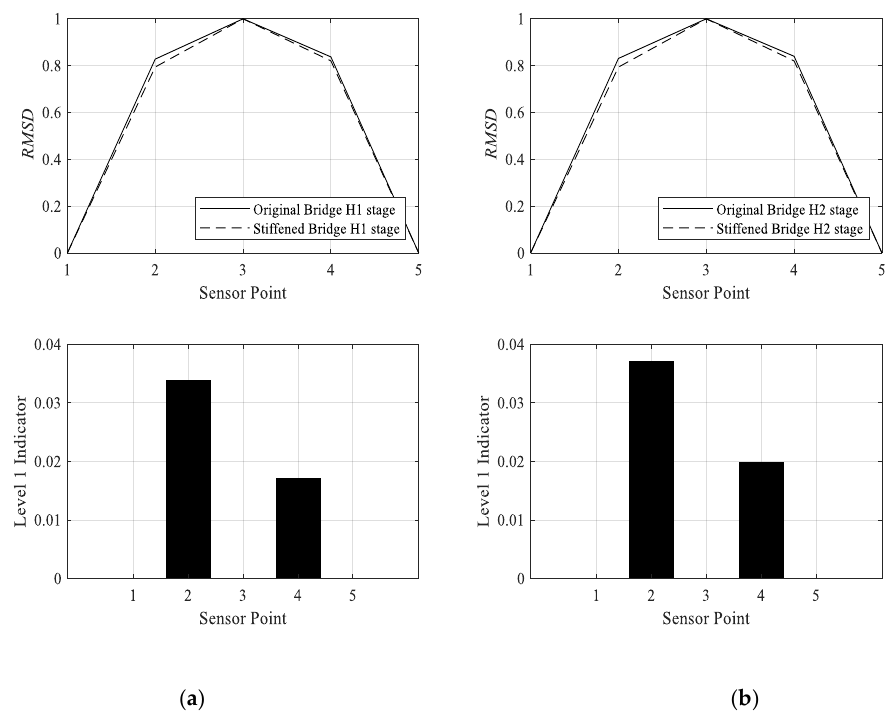
Figure 17. Level 1 damage indicator of ( a ) original and sti ff ened bridges in H1 direction; ( b ) original and sti ff ened bridges in H2